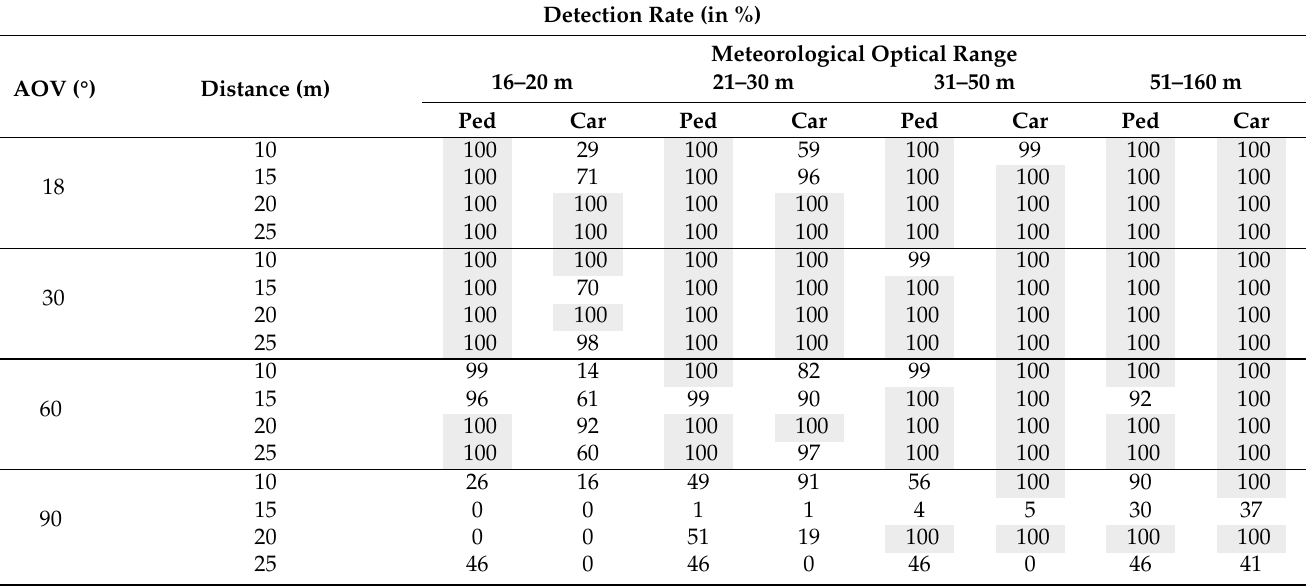
Table 5. Detection rates obtained from YOLO. MOR from 16 m to 160 m. Detection Rate (in